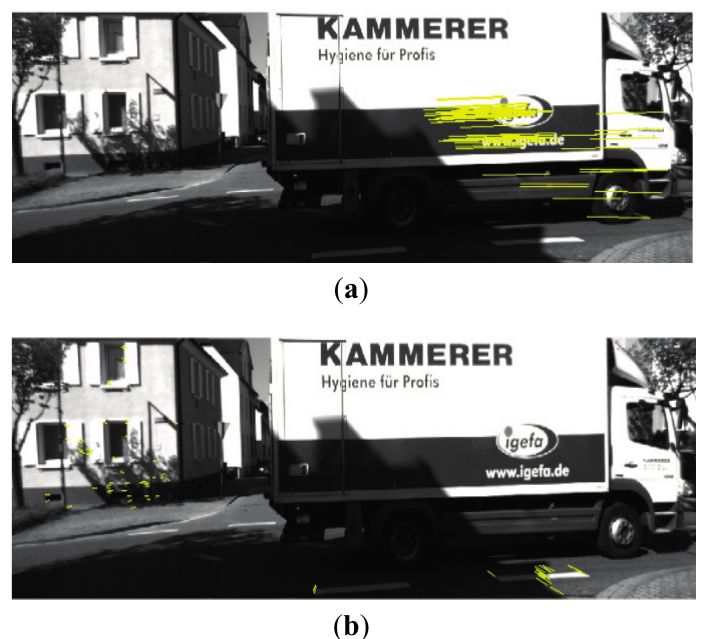
Figure 15. Moving obstacle causes complex situation with high outlier percentage. Yellow lines denote false feature correspondences. ( a ) Inliers preserved by 5-point RANSAC; ( b ) Inliers preserved by